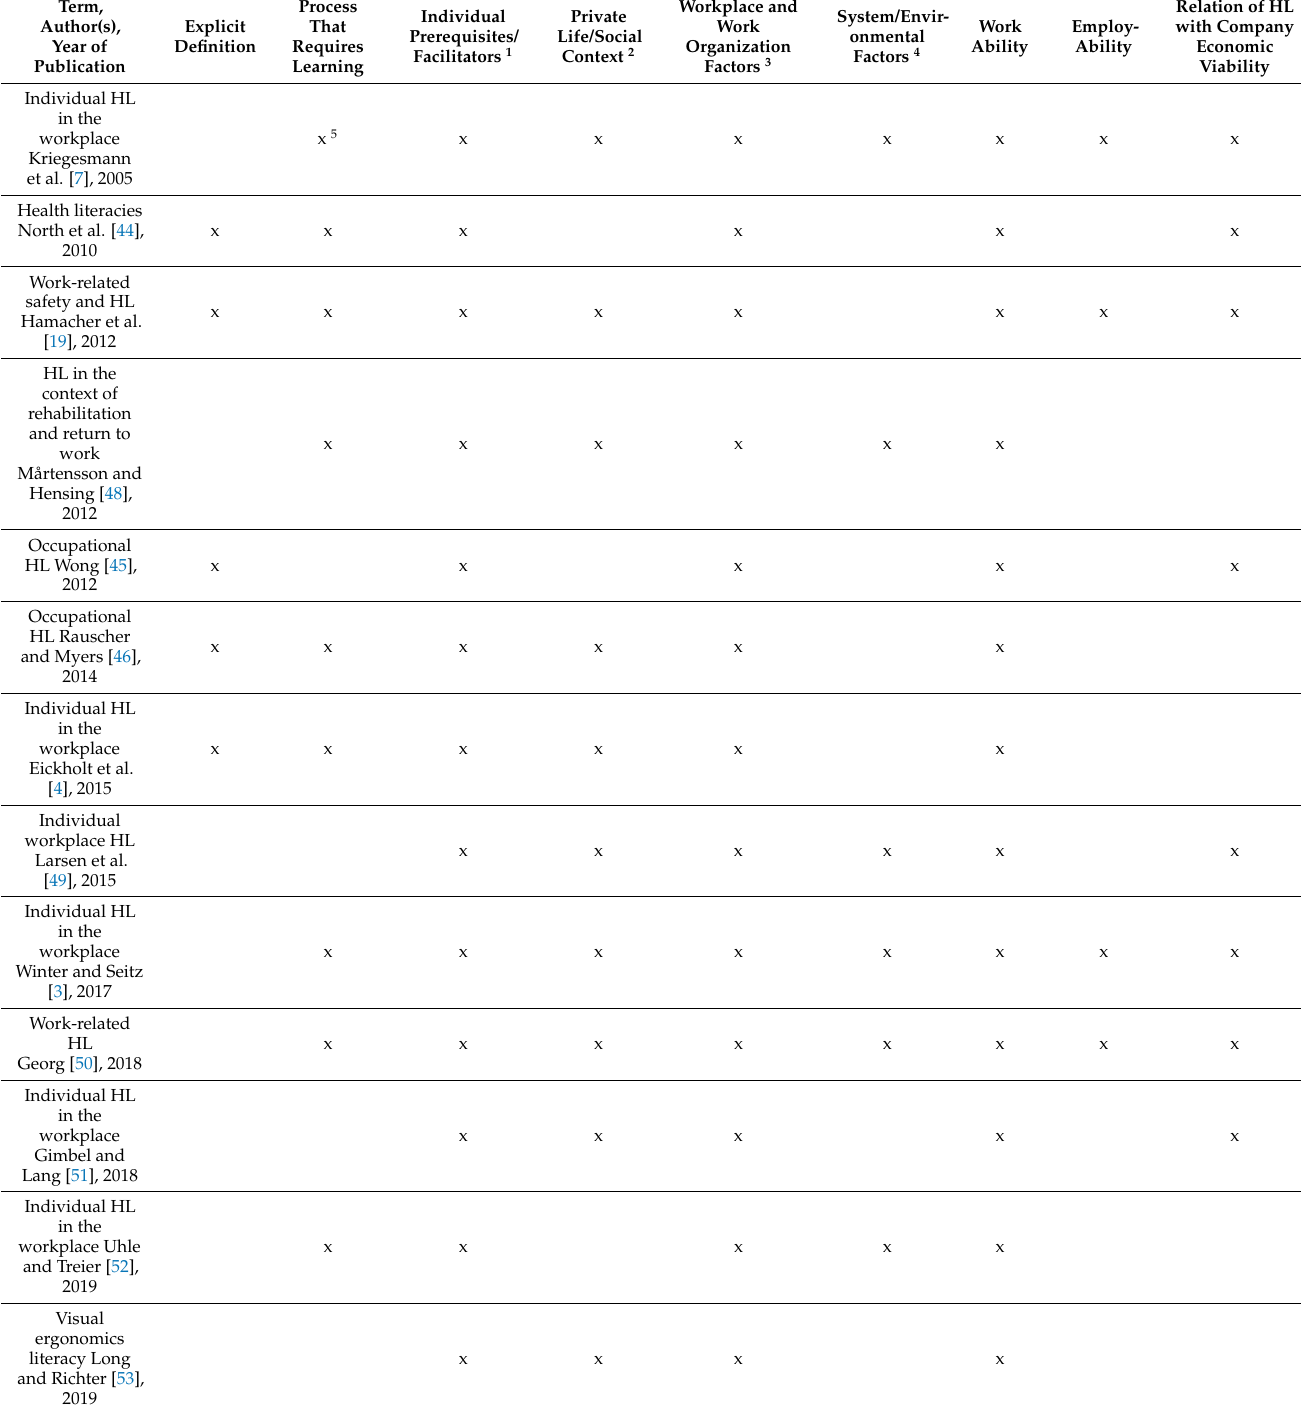
Table 2. Patterning chart: main components addressed in theoretical statements on individual work-related health literacy (HL = health